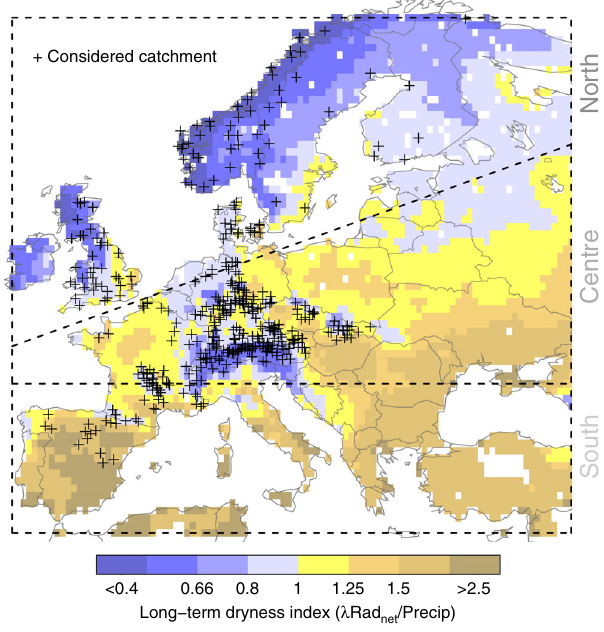
Fig. 1 Study locations and their climate. Considered European climate regions, de fi ned as in ref. 1 , and catchments therein. Colors denote climate regime as determined by dryness index